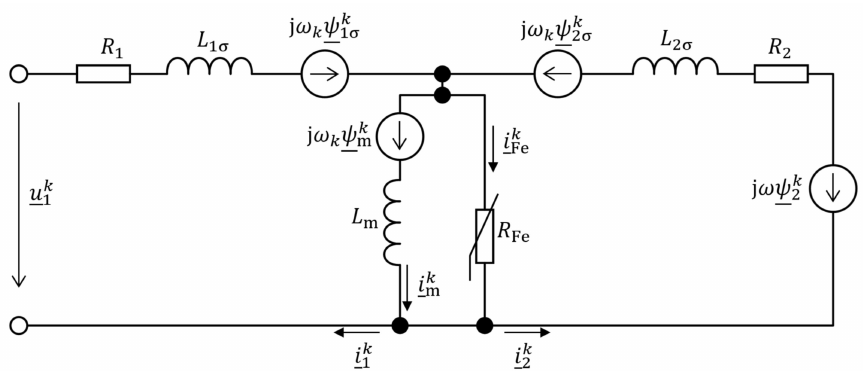
Figure 1. Induction machine T-equivalent circuit with the included effect of iron losses. The superscript k denotes that the space vectors are expressed in an arbitrary reference frame. The two specific reference frames used in this paper are the stator-fixed (real and imaginary axis denoted as α and β , respectively) and rotor flux vector-attached (real and imaginary axis denoted as d and q , respectively) reference